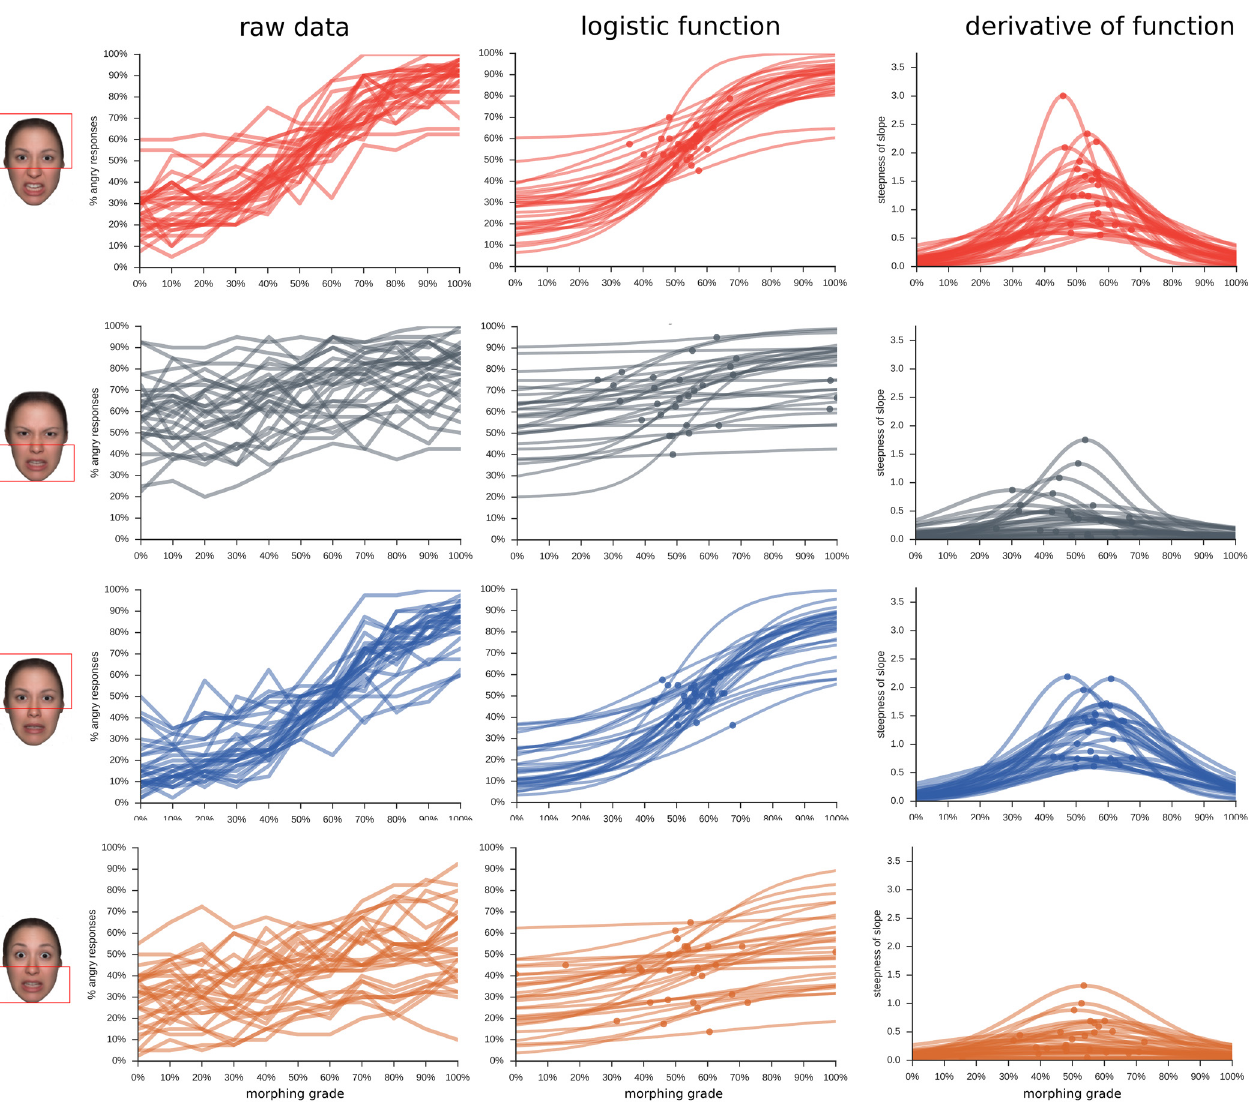
Fig 7. Data on single participant level. Each line represents a participant; each row of the figure indicates a composite face condition, as illustrated by the example stimulus on the left-hand side. Each column indicates a different metric describing the data: 'raw data', the original data for each participant; 'logistic function', the best-fitting logistic function for each individual participant, with point of steepest slope indicated by a dot; 'derivative of function', the slope of the fitted logistic function, with the highest value indicated by a